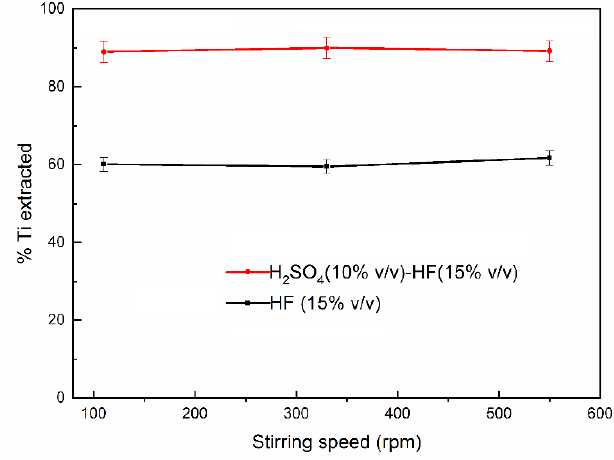
Figure 8. E ff ect of stirring Figure 8. Effect of stirring speed.